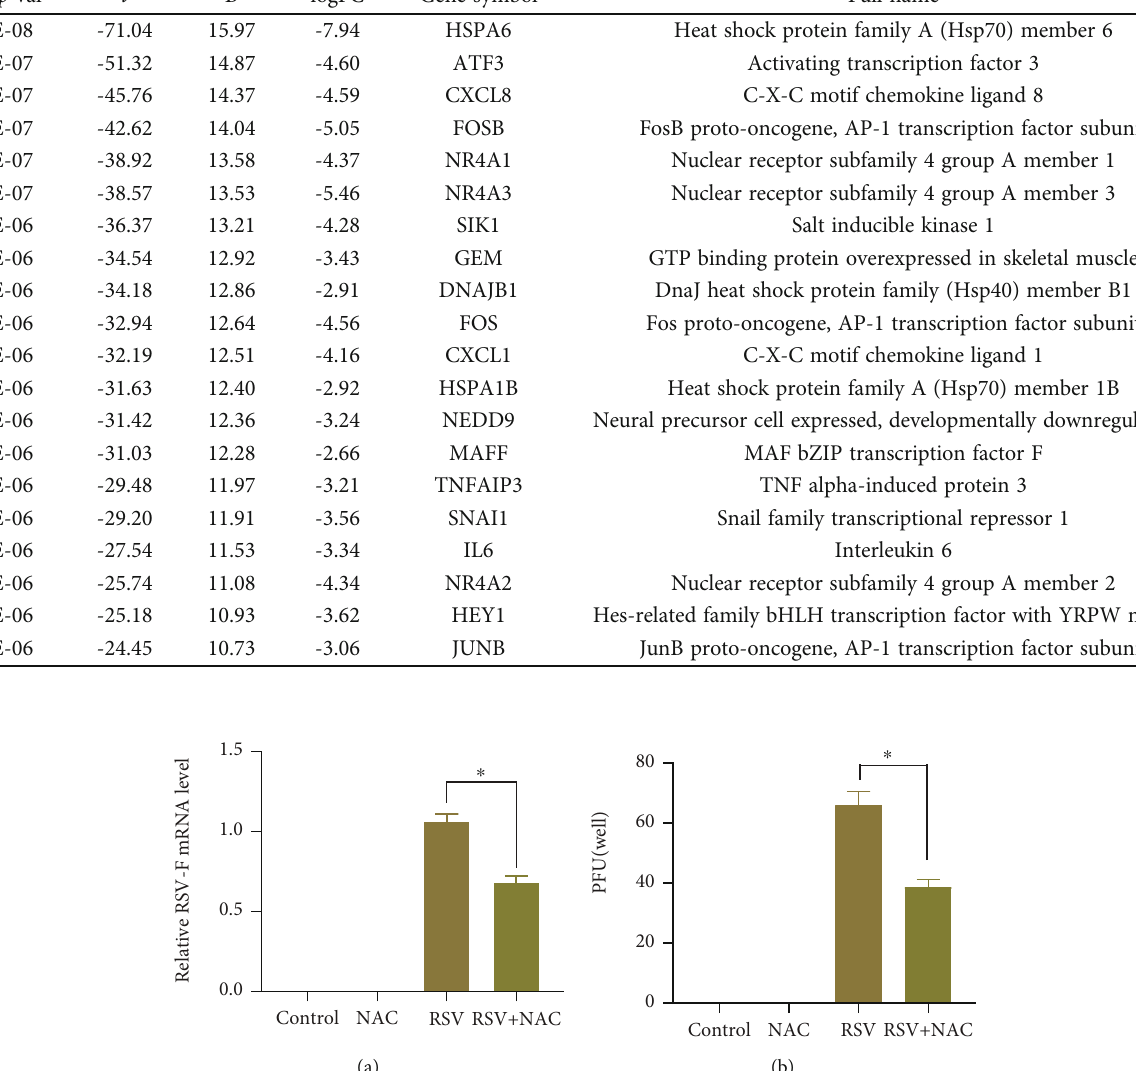
Figure 6: Antiviral activity of NAC in RSV-infected BEAS-2B cells. Quantitative real-time PCR (a) and plaque assay (b) were performed to examine the mRNA expression of RSV-F and the number of virus-induced plaques formed in RSV-infected BEAS-2B cells. ∗ indicates p < 0 : 01